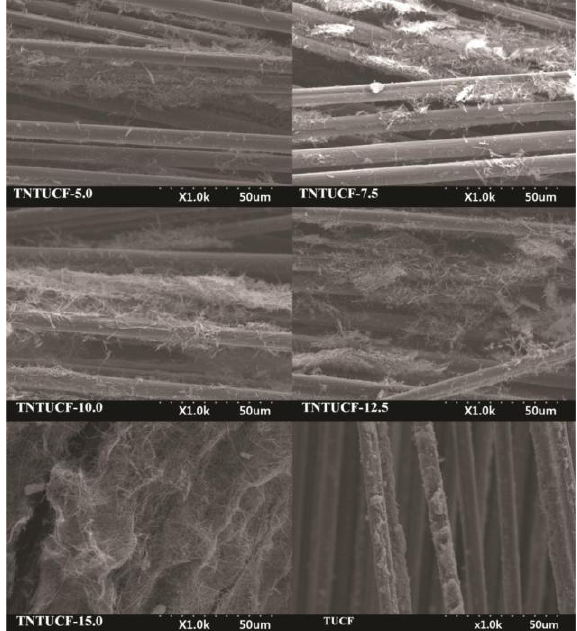
Figure 9. Scanning electron microscopy (SEM) of titania nanotube arrays grown on un-activated carbon fibers (TNTUCFs) with different TiO 2 loadings (TNTUCF-5, TNTUCF-7.5, TNTUCF-10, TNTUCF-12.5, TNTUCF-15) and TiO 2 -coated UCF (TUCF). Reproduced with permission from [69].